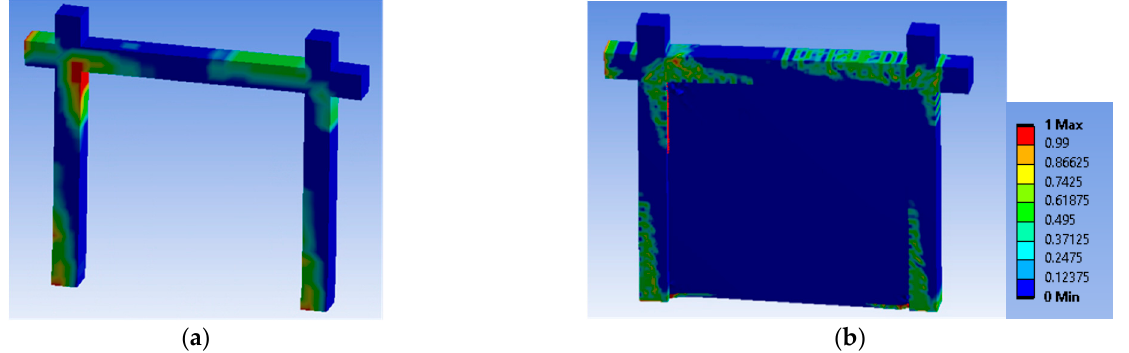
Figure 16. Concrete damage of ( a ) specimen A1F with no corrosion/no lap splices and ( b ) specimen B2 with no corrosion/no lap